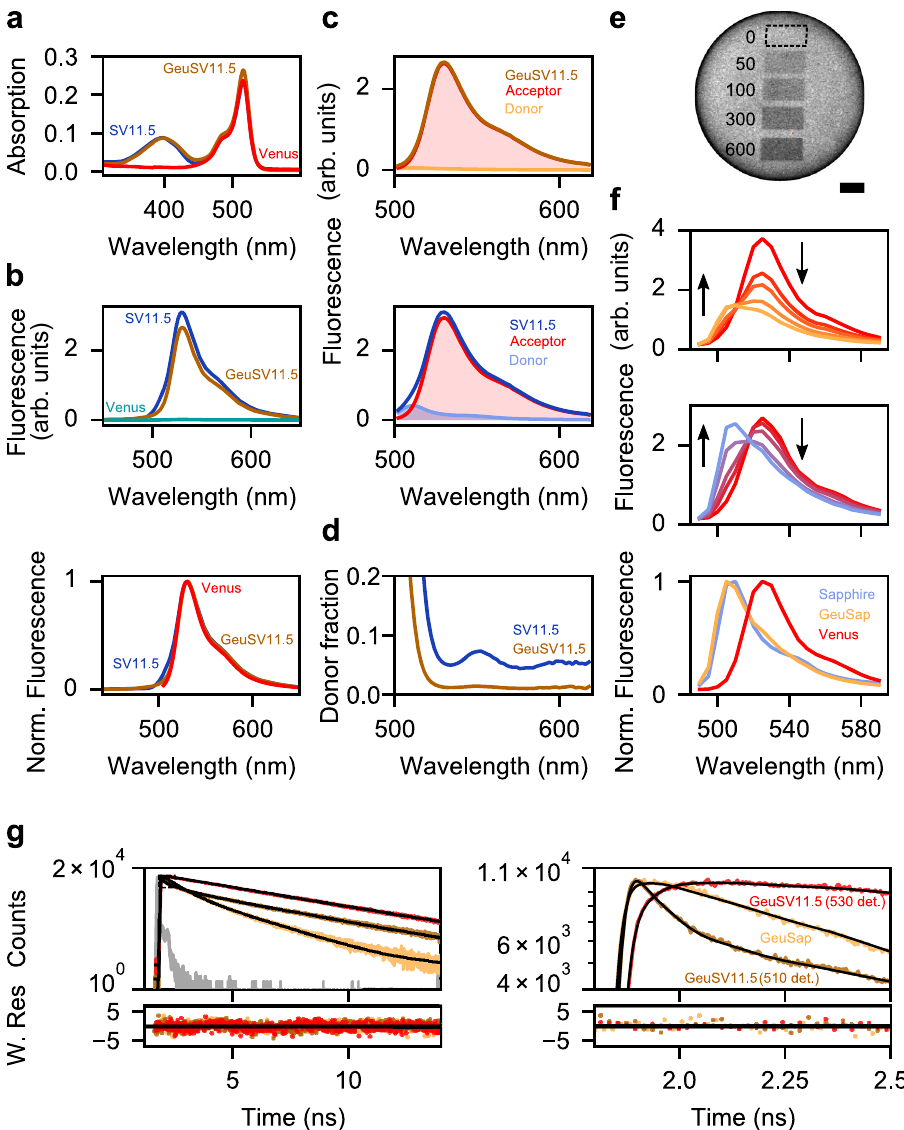
Fig. 2 Characterization of the GeuSV11.5 FRET system. a Absorption of GeuSV11.5 and SV11.5 adjusted to 0.1 at 400nm, and Venus absorption adjusted accordingly to match the OD of SV11.5 at 516 nm. b Top: Emission spectra of GeuSV11.5, SV11.5, and Venus, corresponding to the absorption shown in a and excited at 400nm. Bottom: Normalized emission spectra of GeuSV11.5 (400 nm excitation), SV11.5 (400 nm excitation), and Venus (490 nm excitation). c Linear unmixing performed on GeuSV11.5 (top) and SV11.5 (bottom). d Fractions of donor to total signal in the case of GeuSV11.5 and SV11.5, calculated based on the linear unmixing result. e GeuSV11.5 immobilized on a Ni-NTA bead and imaged with a laser scanning microscope under 400 nm excitation. Dark rectangles correspond to increasing photobleaching cycles performed on Venus with a 488-nm laser. The experiment was repeated 3 times with essentially the same results. Scale bar is 10 µ m. f Emission spectra of GeuSV11.5 (top), and SV11.5 (middle) recorded under 400nm excitation, each curve corresponding to the non- and photobleached areas shown in e . Arrows indicate progression of bleaching. Bottom panel shows normalized emission spectra of donors alone (GeuSap, Sapphire), and acceptor alone (Venus). g Fluorescence decays and fi ttings of GeuSap (510 nm detection, χ 2 = 1.2), GeuSV11.5 (510 nm detection, χ 2 = 1.2), and GeuSV11.5 (530nm detection, χ 2 = 1.15). Excitation was at 400 nm. The dashed rectangle corresponds to the zoomed-in fi gure on the right. For fi tted lifetimes and amplitudes, refer to Supplementary Table 3. Norm. Fluorescence: normalized fl uorescence; W. Res.: weighted residuals. Source data are provided as a Source Data fi